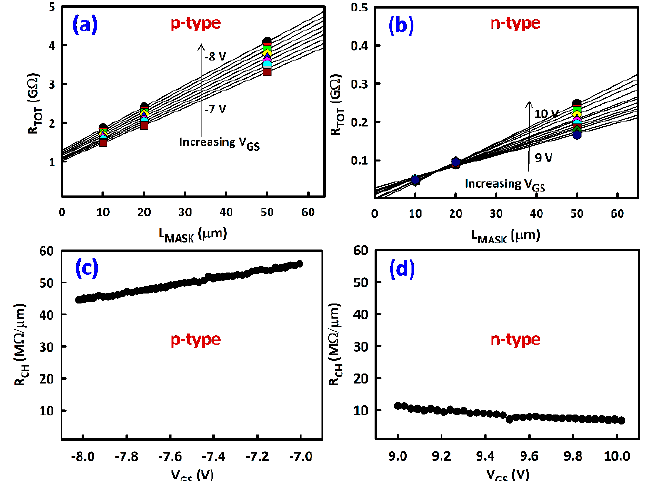
Figure 11. Extraction of channel resistance (R CH ). ( a , b ) Linear regression of the TFT’s total resistance (R TOT = V DS / I D ), as a function of the design channel length (L MASK ) for ( a ) p-type, and ( b ) n-type characteristics. ( c , d ) R CH per micrometer (of L) as a function of L MASK for ( c ) p-type and ( d ) n-type characteristics.